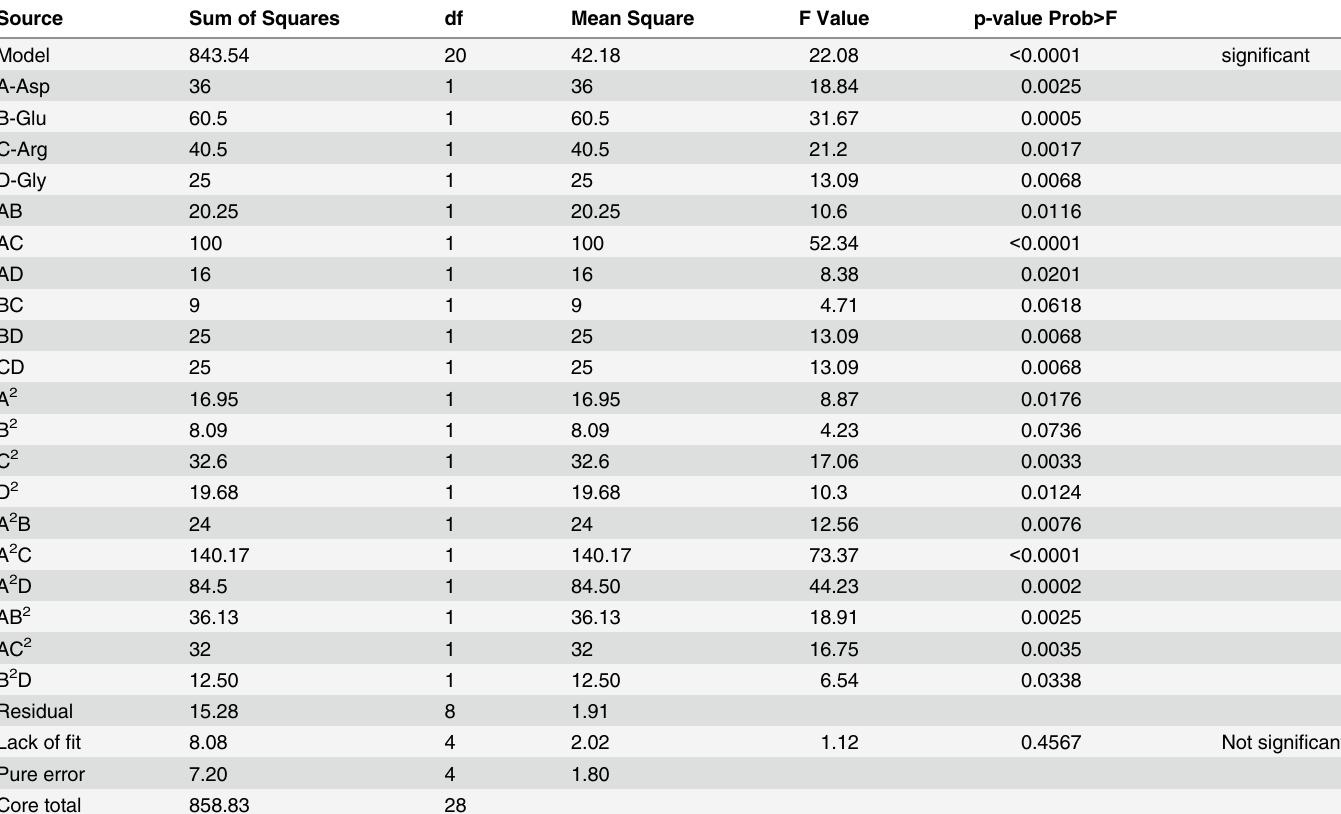
Table 8. ANOVA results for RSM (Box-Bencken) analysis for the final mAb titre response. Source Sum of Squares